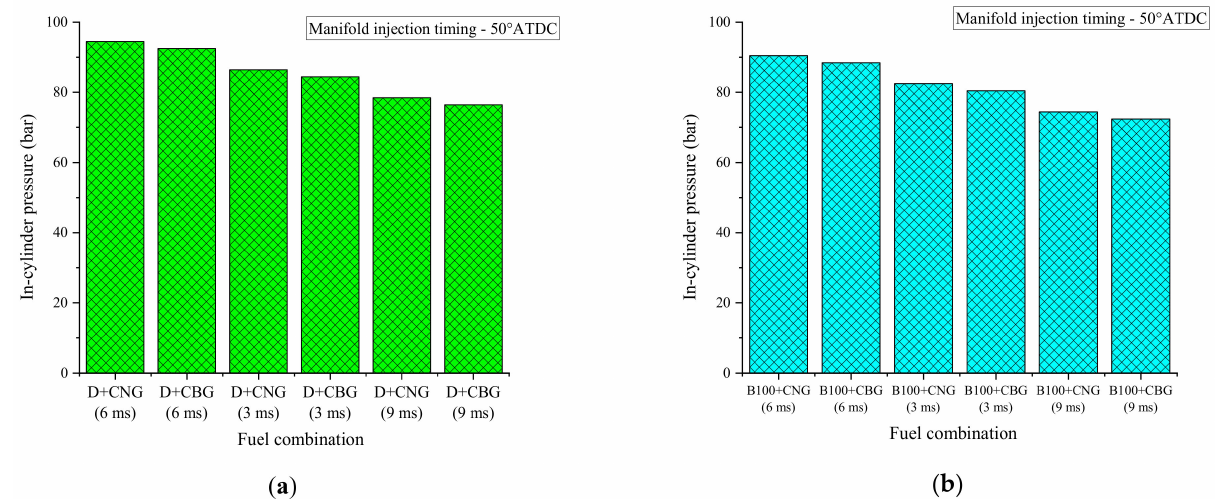
Figure 14. Variation of ICP with fuel combination at different IDs. ( a ) Variation of ICP with fuel combination for diesel as DIF. ( b ) Variation of ICP with fuel combination for B100 as DIF.